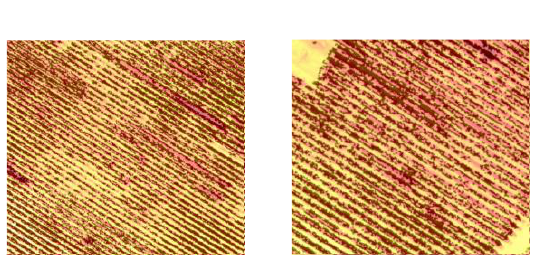
Figure 11: Expanded views of “Region 1” in Figure 10 (left) and the corresponding VIS DPC (right). In the left hand image the superimposed black dots indicate segments identified as vines, whereas yellow and red colouring below these dots indicate higher (likely between row material) and lower (likely vine material) ground temperatures, respectively